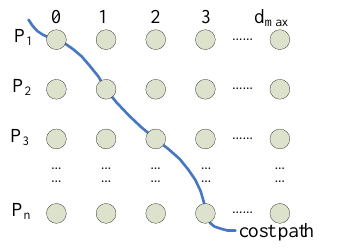
Figure 1. Disparity space. There are n pixels, namely P 1 , P 2 , ..., P n , and their disparities are ranged from 0 to d max . The cost path relates to the assignment of disparities for each pixel.